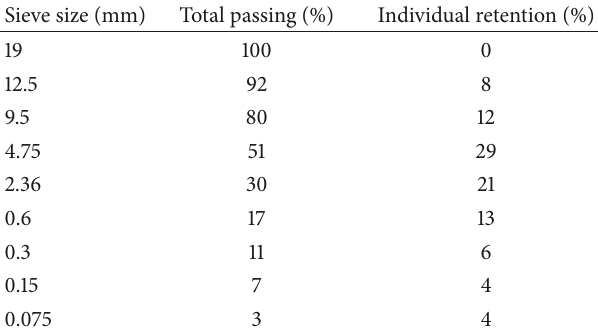
Table 1: The aggregate